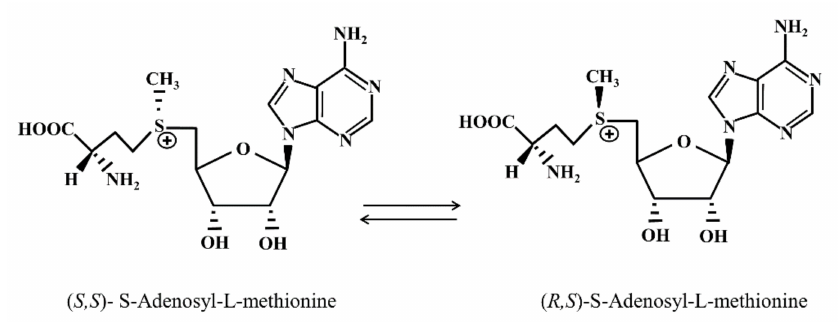
Figure 1. Conformations of